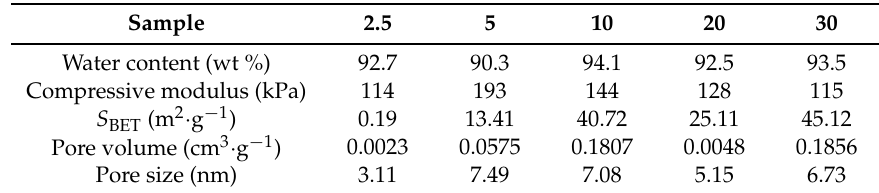
Table 1. Water content, compressive modulus, surface area, pore volume, and pore size of GO( x )/cellulose(100) hydrogels with x = 2.5, 5, 10, 20, and 30, respectively.